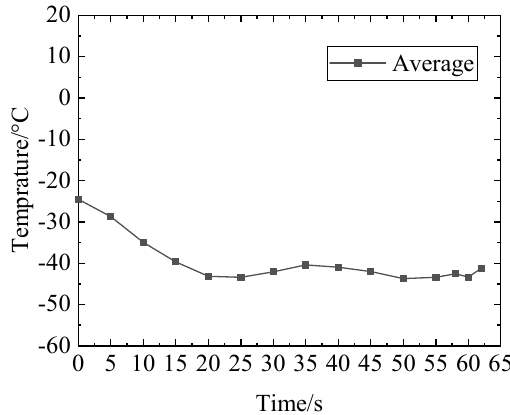
Table 5. Experimental data of three stages under the heat flux of 400 W/m 2 .